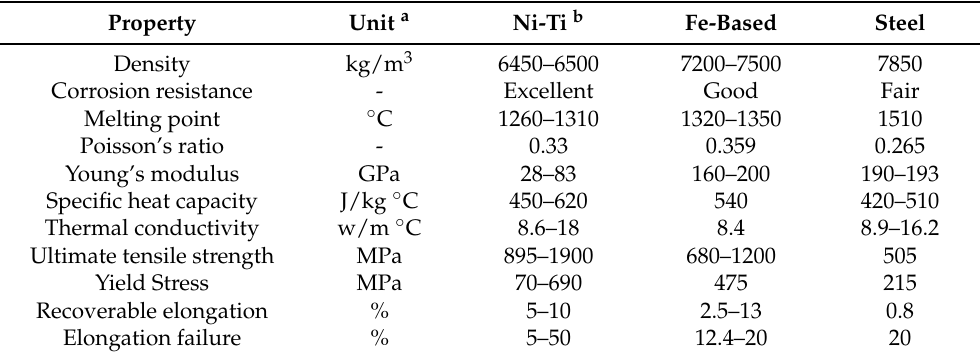
Table 3. Comparison of physical and mechanical characteristics of Ni-Ti and Fe-based SMAs and stainless